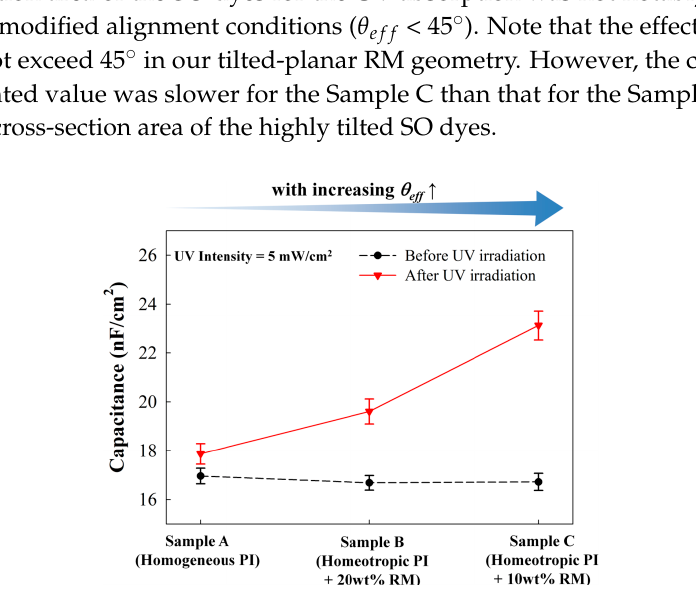
Figure 6. Capacitances of guest-host films with the MIM structure depending on the alignment layer conditions before and after UV irradiation.